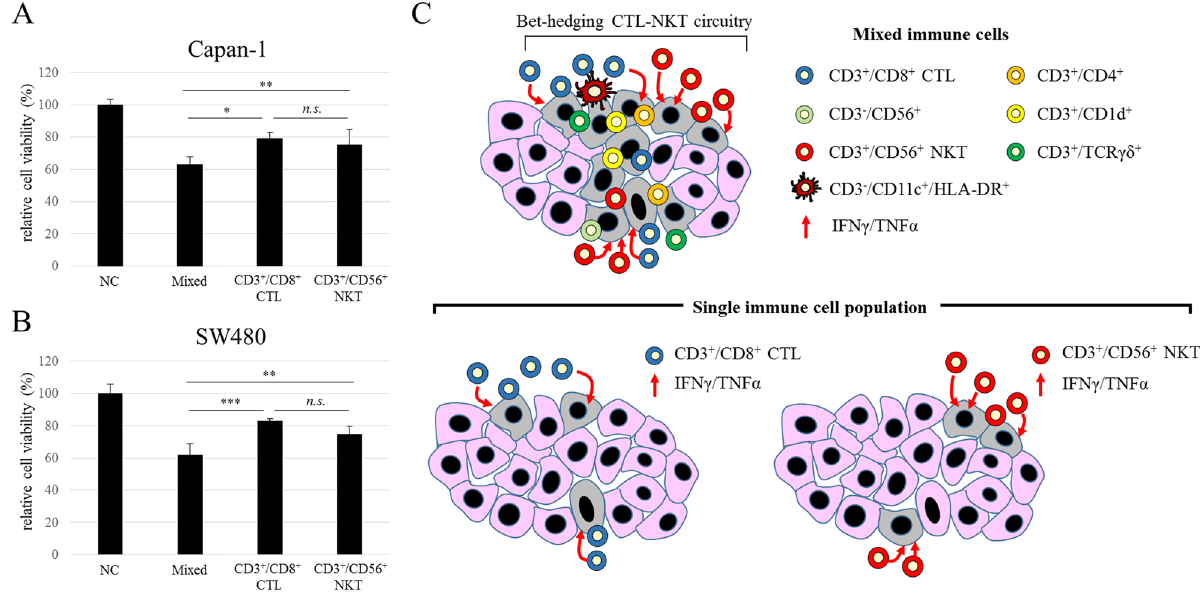
Figure 5. Comparison of cytotoxicity of mixed immune cells and single-cell populations. Cytotoxicity of mixed immune cells and single cell populations of CD3 + /CD8 + CTLs and CD3 + /CD56 + NKT cells against ( A ) Capan-1 and ( B ) SW480 cells (E:T ratio = 10:1, n = 4). The data are shown as means ± SD. n.s . not significant. * p < 0.01, ** p < 0.05, *** p < 0.0005 (one-way ANOVA with Tukey analysis). ( C ) Diagram of tumor cell-killing activity of mixed immune cells and single-cell